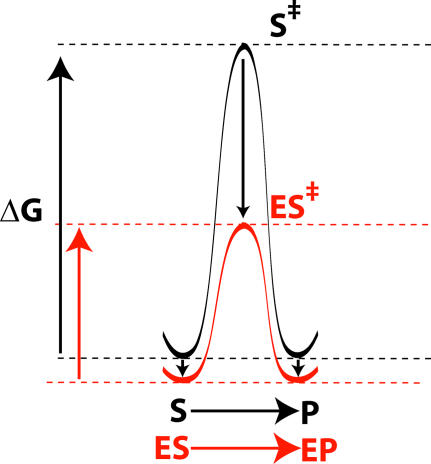
Catalysis Is Preferential Transition State Stabilization